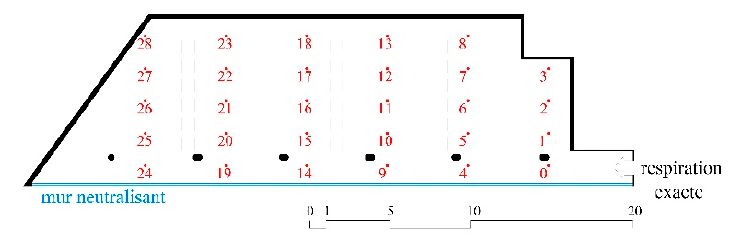
Figure 4. Probe points to measure the indoor temperature marked in red.